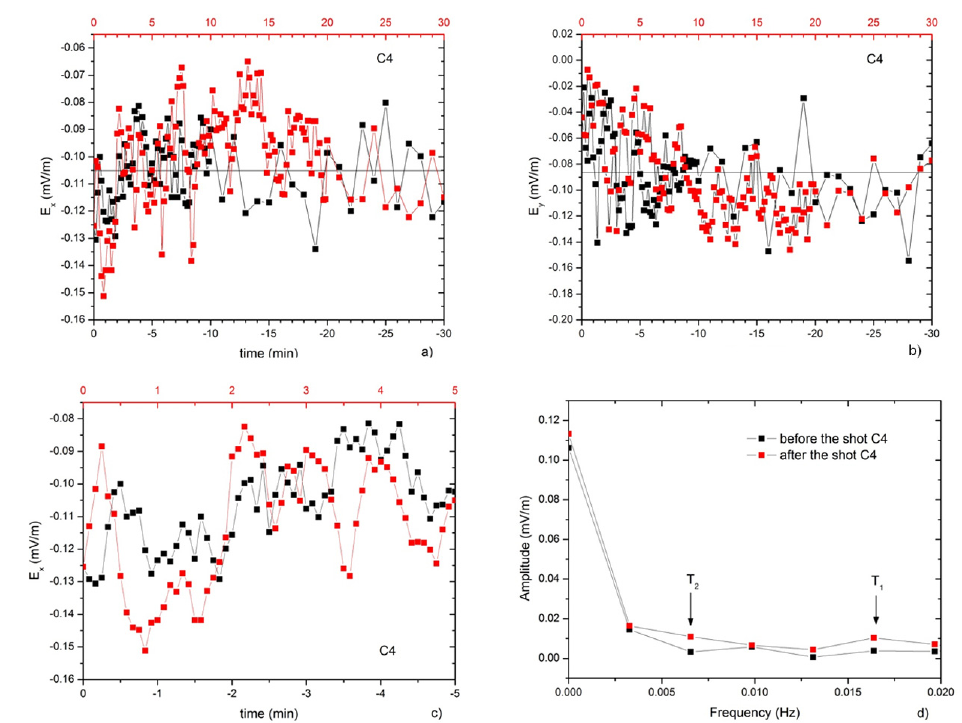
and E (in mV/m), observed along the AB and AC dipoles and related to the shot in C4, are Figure 4. Natural electric field components, E x y component registered with the short step (5s) 5 min before and 5 min after the shown respectively in (a) and (b). (c) Time series of the E x shot. Black symbols are used for data measured before the shot, while red symbols are used for data registered after the shot. The zero time of both the black and red scales corresponds to the shot time. The black continuous line represents the average value of the field compo- nent before the shot. (d) FFT of the signal shown in (c).